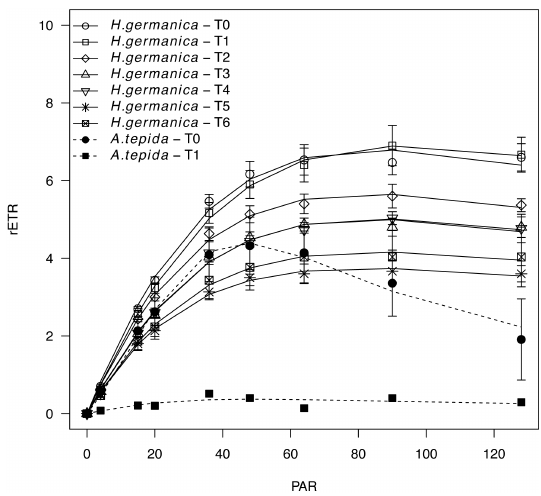
Figure 5. Rapid light curves (RLC, n = 3) expressed as the relative electron transport rate (rETR) as a function of the photosynthetic active radiation (PAR in µmolphotonsm − 2 s − 1 ) of Haynesina ger- manica (black lines) and Ammonia tepida (black dashed lines) dur- ing the 7days of the